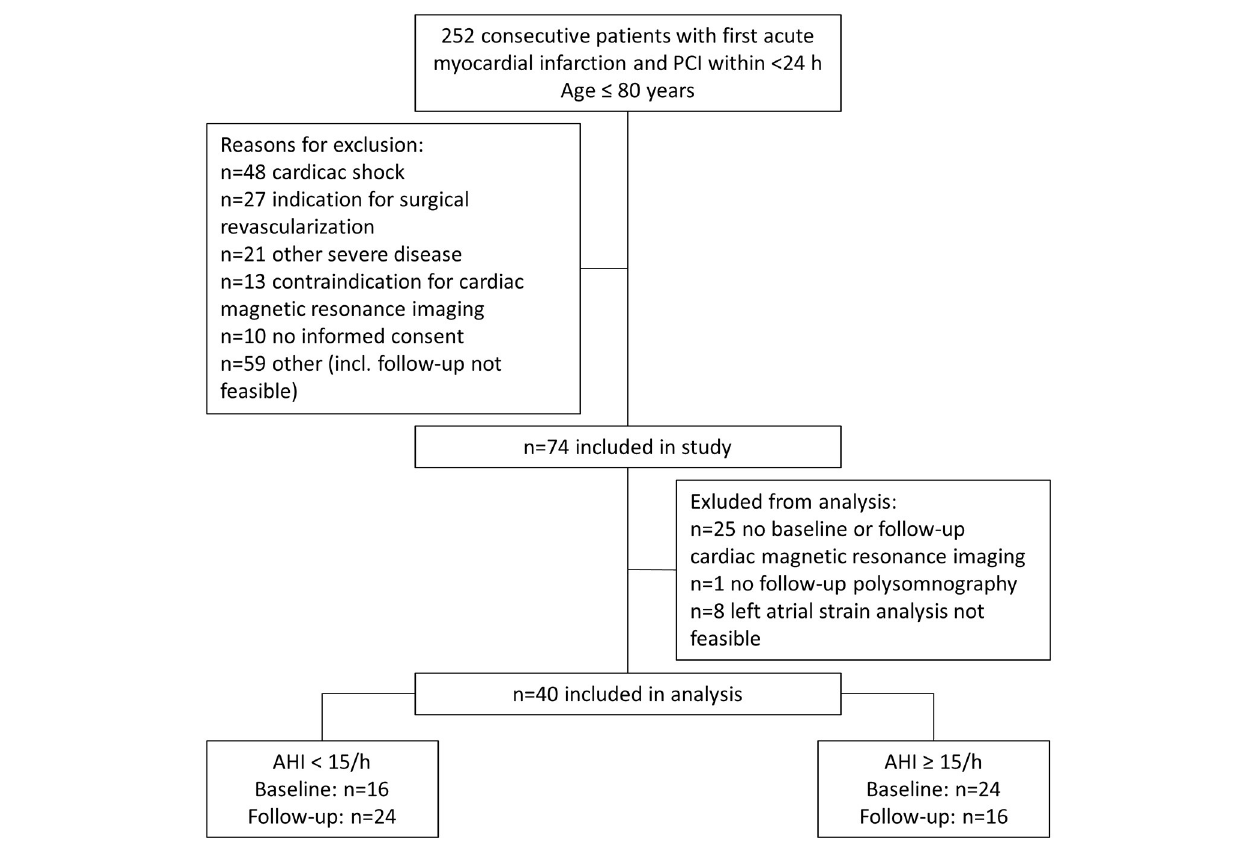
FIGURE 1 | Flow diagram of patients included in the study for analysis at baseline and follow-up. AHI, apnea-hypopnea index; PCI, percutaneous coronary intervention.